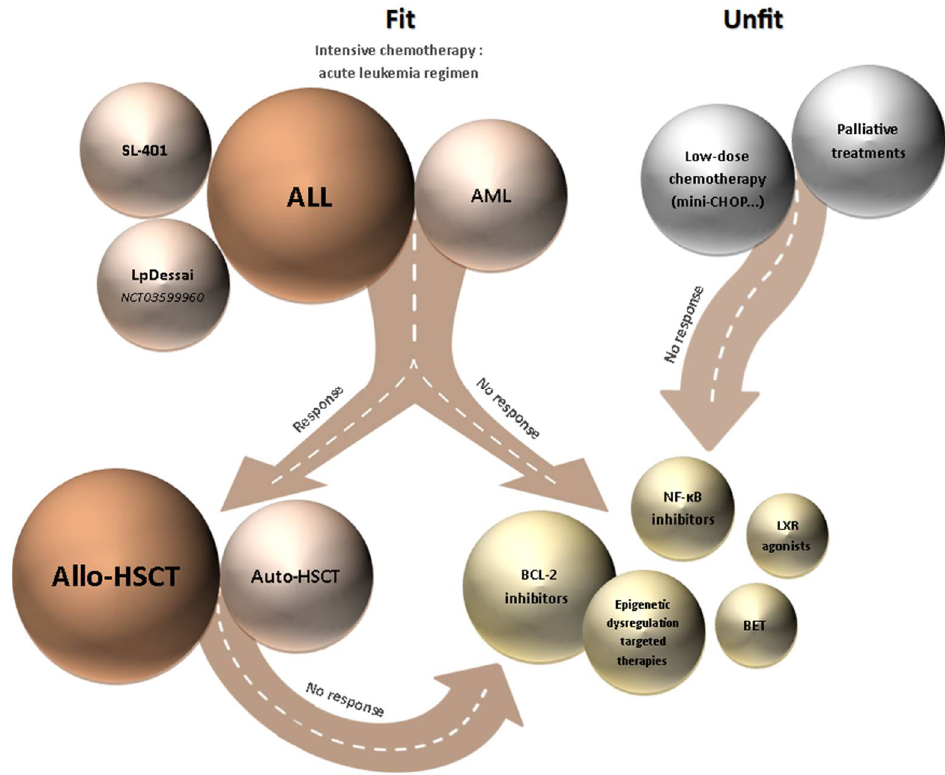
Figure 2. Diagram of current BPDCN management. The size of the circles represents the efficacy and frequency use of the treatment. The color of the circle represents the patient group the treatment is recommended to (fit (orange), unfit (gray), or after several failures (gold)). ALL, acute lymphoid leukemia; AML, acute myeloid leukemia; Allo-HSCT, allogenic hematopoietic stem cell transplan- tation; Auto-HSCT, autologous hematopoietic stem cell transplantation; BET, bromodomain and extraterminal domain; LXR, liver X receptor.